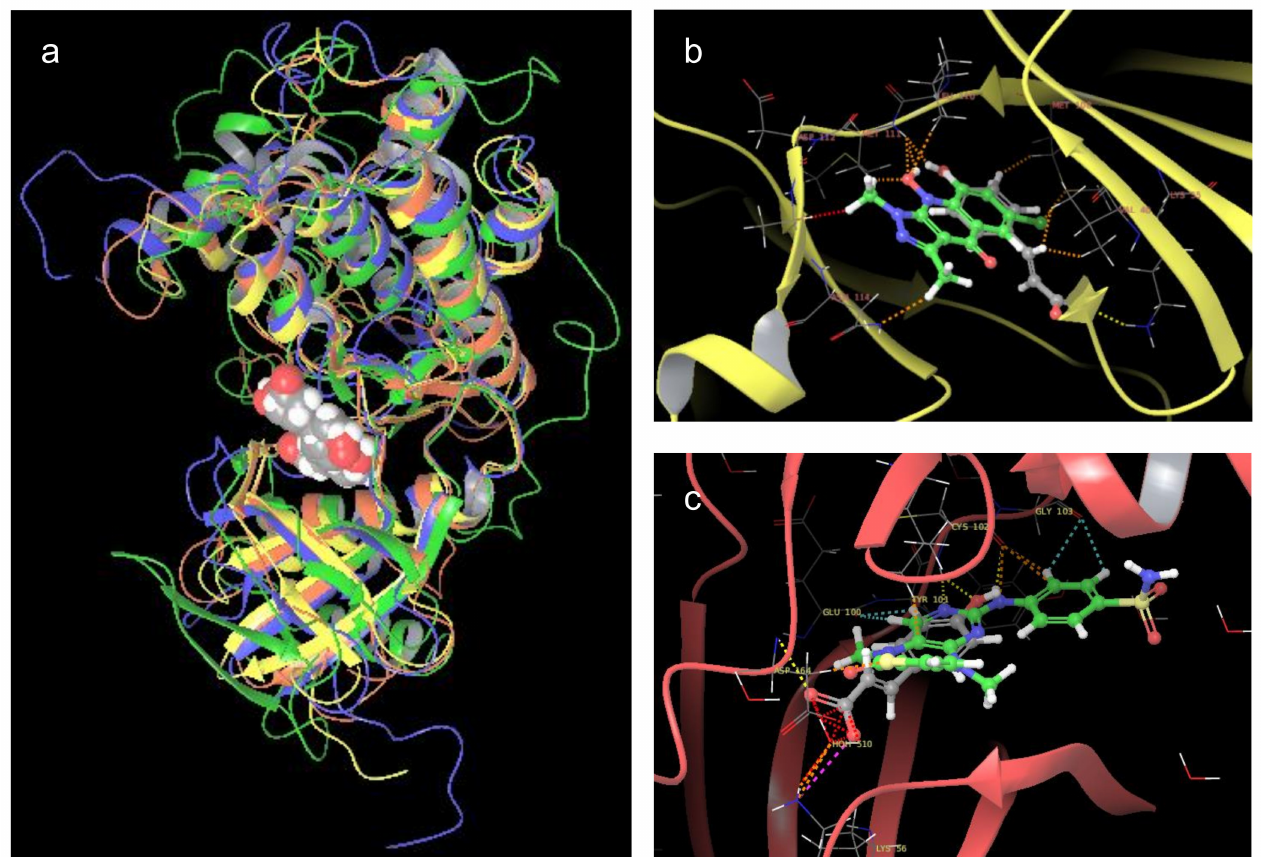
Figure 1. ( a ) Conserved protein structure motif alignment for mitogen activated protein kinase kinase kinase 1 (MAP3K1, green), mitogen activated protein kinase 8 (MAPK8, yellow), MAP kinase-interacting Serine/Threonine kinase 2 (MKNK2, blue), and human Serine/Threonine-protein kinase 3 (STK3, red) that bound with the best poses of p -coumaric acid ( p -CA) for each protein. ( b ) JNK inhibitor II (green) and p -CA bound to MAPK8. ( c ) Xmu-MP-1 (green) and p -CA bound to STK3. These images were made with the Maestro